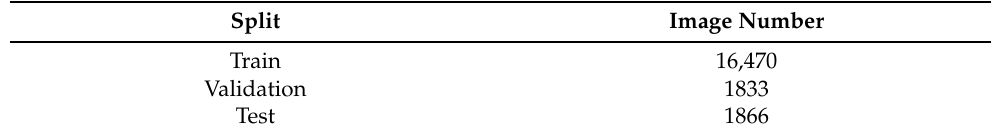
Table 1. Size of xBD dataset split.